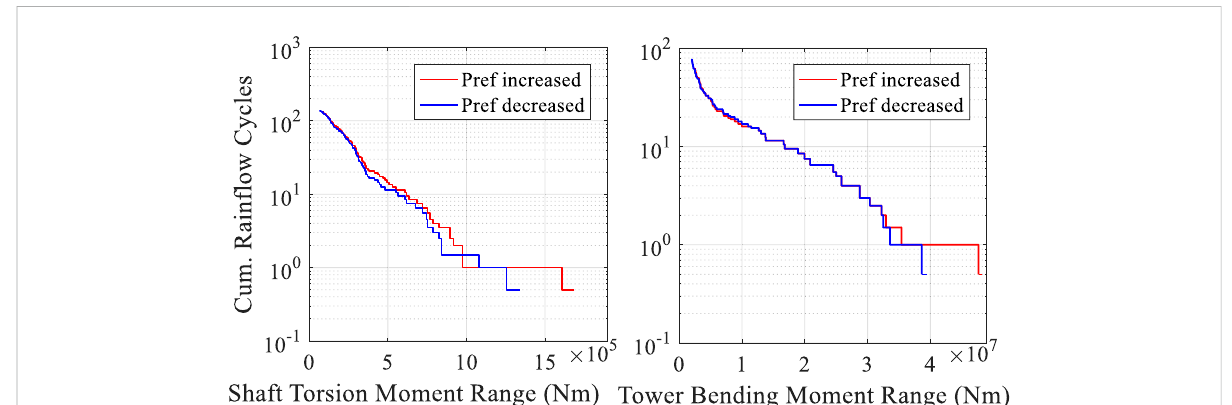
FIGURE 8 Cumulative rain fl ow cycle results of the WT shaft and tower under different reference power and wind velocity values.